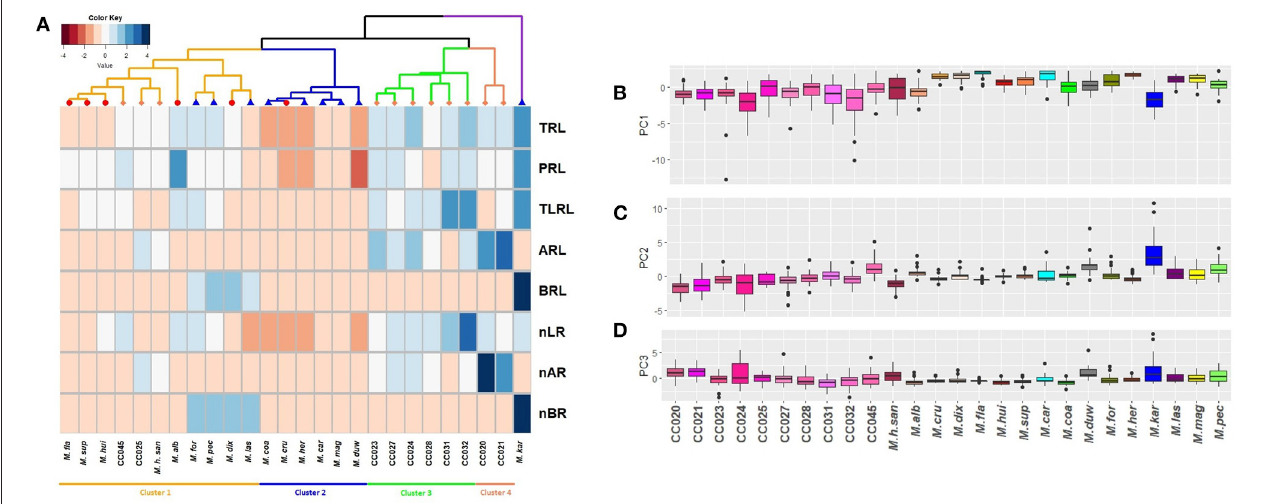
FIGURE 6 | Trends of phenotypic variation at different evolutionary levels. (A) Clustering (Euclidean distance) of Mammillaria accessions according to their root architecture phenotypes at 129 days after germination developmental stage. On dendrogram, coral rhomboids represent M. haageana accessions, red circles represent Supertextae series species, and blue triangles represent non- Supertextae series species. TRL, Total Root Length; PRL, Principal Root Length; TLRL, Total Lateral Root Length; ARL, Adventitious Root Length; BRL, Basal Root Length; nLR, number of Lateral Roots; nAR, number of Adventitious Roots; nBR, number of Basal Roots. (B–D) Boxplots of each of the 3 Principal Components that together captured 90.6% of the variation. Significant differences are shown with